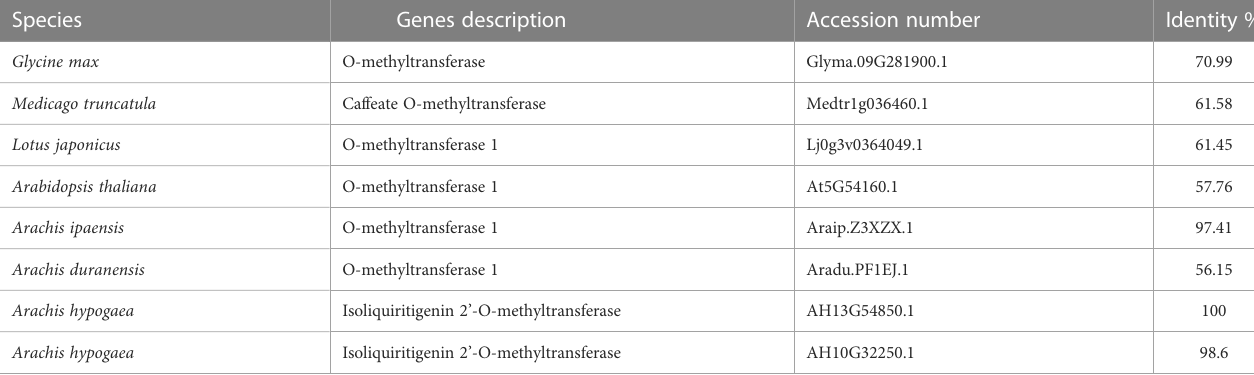
TABLE 2 Comparison of AhOMT1 to homologous genes from other legume species.